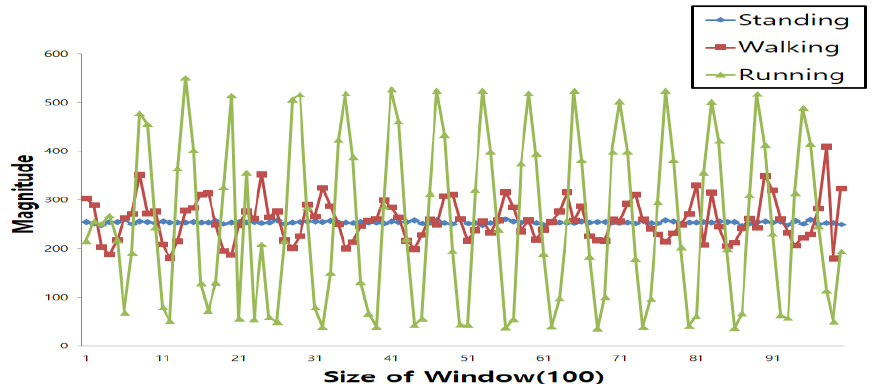
Figure 8. Signal vector magnitude (SVM) during standing, walking, and running when the safety helmet is worn properly.